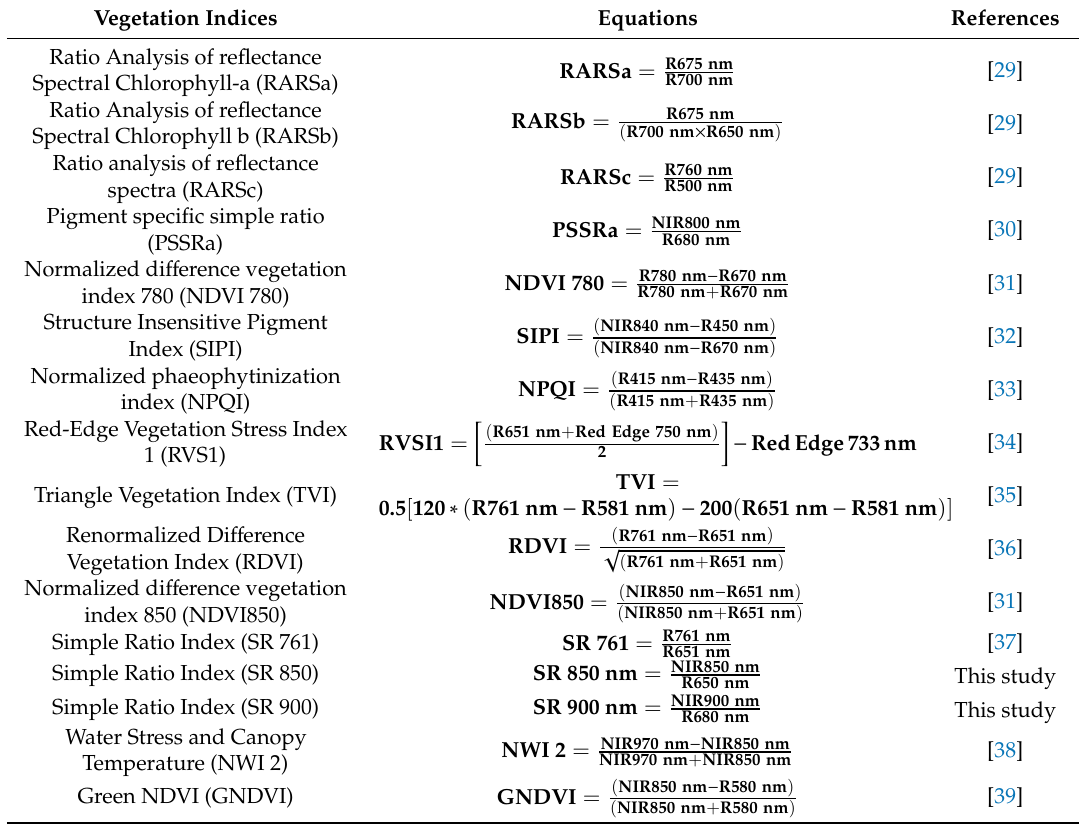
Table 1. Vegetation indices evaluated for disease